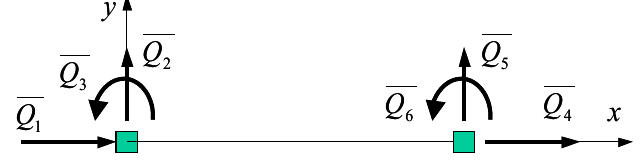
Figure 6. FE with rigid body modes.